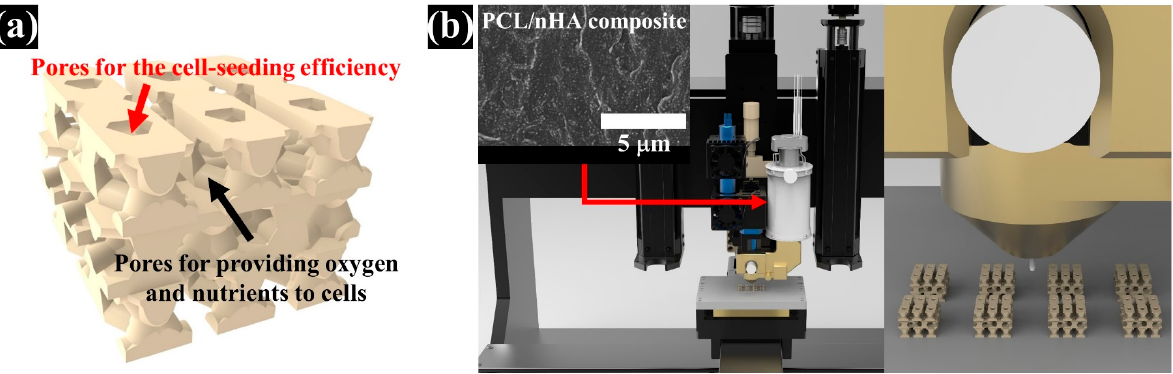
Figure 1. Schematics of the 3D-printed scaffolds with dual-pore kagome-structures: ( a ) 3D image of designed dual-pore scaffold; ( b ) 3D-printing system (material-extrusion system).